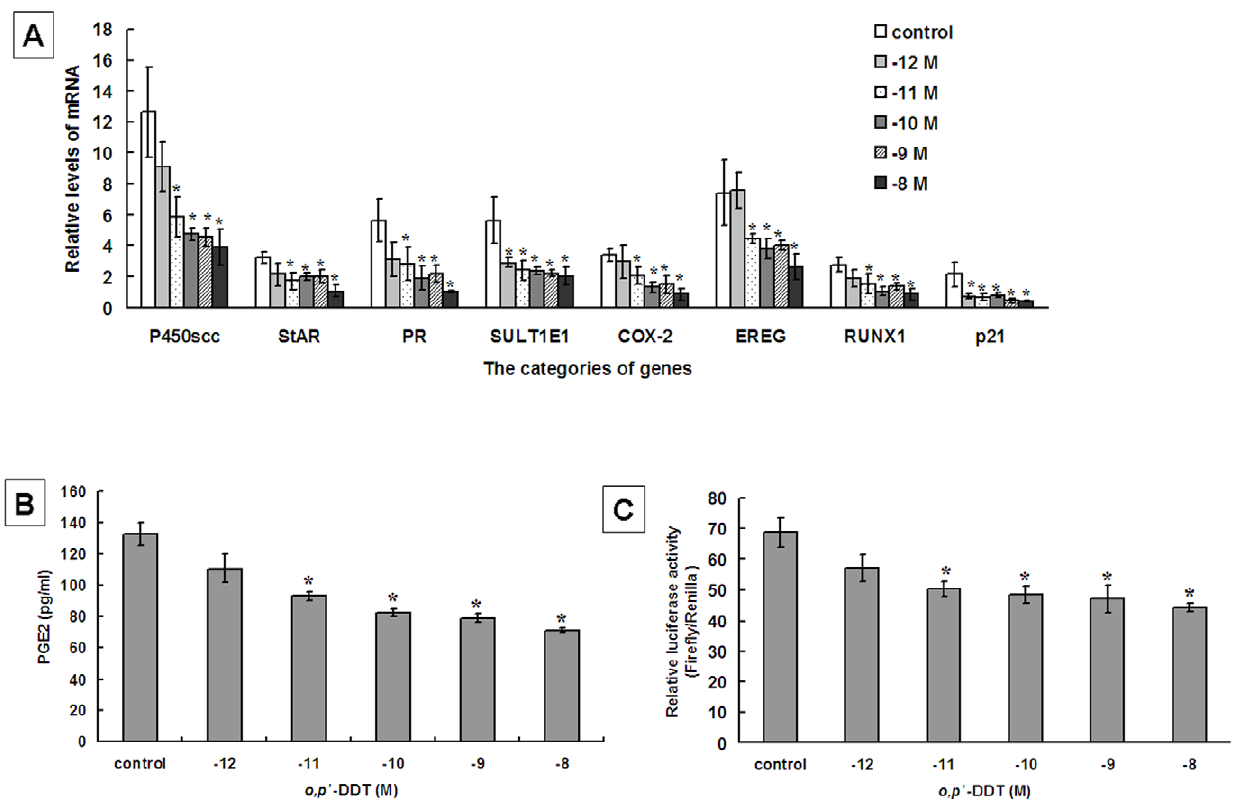
Figure 2. Low concentrations of o,p’ -DDT inhibit invitro gene expression, PGE2 secretion and transcriptional activity of COX-2 promoter in primary cultures of rat ovarian granulosa cells. ( A ) In vitro expression levels of mRNA for ovarian genes in granulsa cells exposed to o,p’ -DDT at concentrations of 10 2 12 2 10 2 8 M. ( B ) Levels of PGE2 in cultured media of rat granulosa cells exposed to o,p’ -DDT at concentrations of 10 2 12 2 10 2 8 M. ( C ) Luciferase activity of COX-2 promoter in granulsa cells exposed to o,p’ -DDT at concentrations of 10 2 12 2 10 2 8 M. The results were shown as mean 6 SEM for three independent experiments performed in triplicate. *, r , 0.05, compared to control.